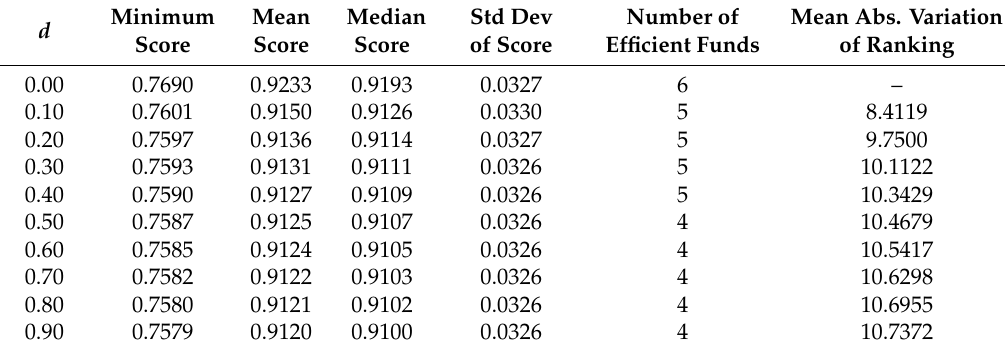
Table 11. Main results for AR restrictions in the case of symmetric bounds and T = 1. Summary statistics on the performance scores (minimum, mean and median values, standard deviation), number of efficient funds and mean absolute variation (divided by 2) of the ranking positions.